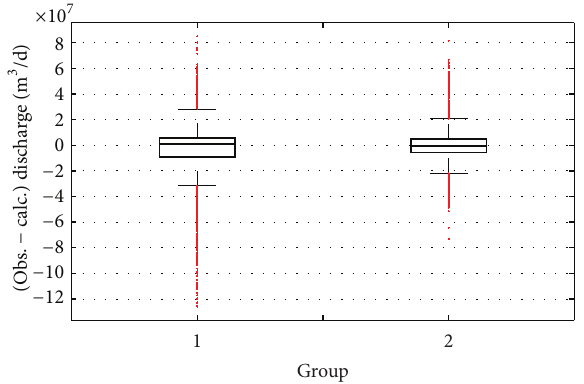
Figure 7: Frequency distribution of the first six years of model residual (group 1) and the last six years (group 2).